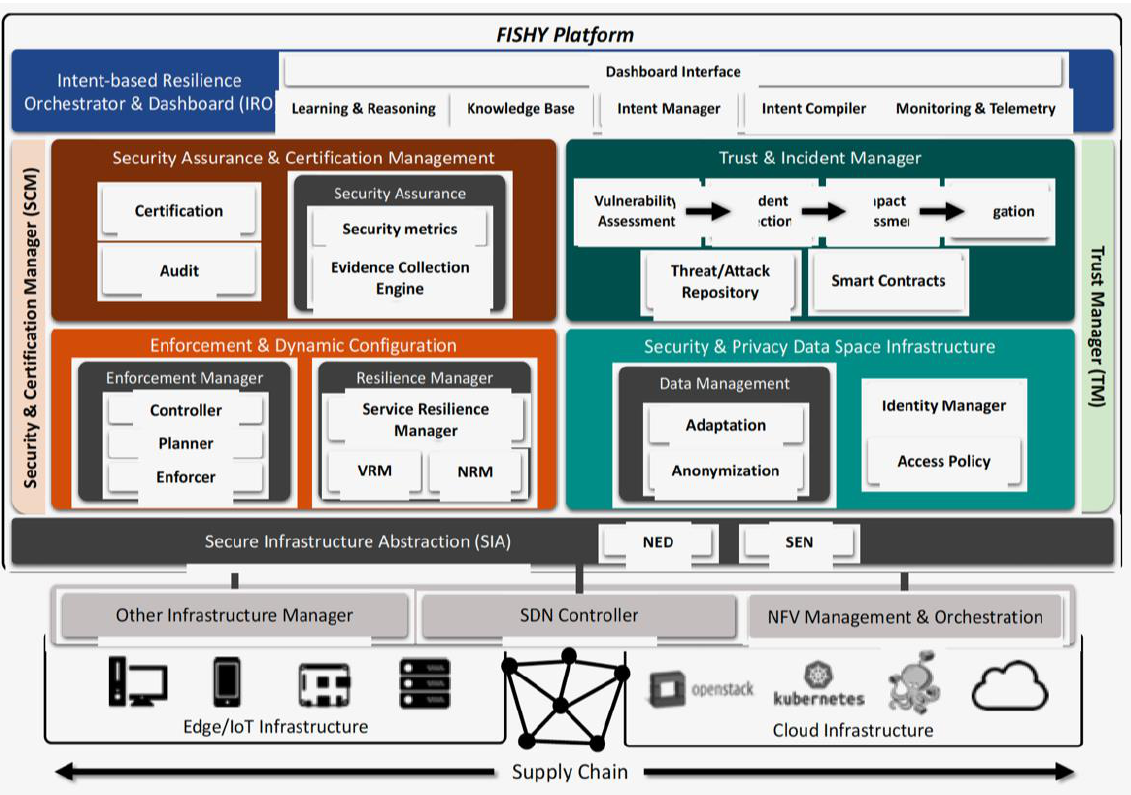
Figure 3. FISHY functional architecture in the entire ICT system.